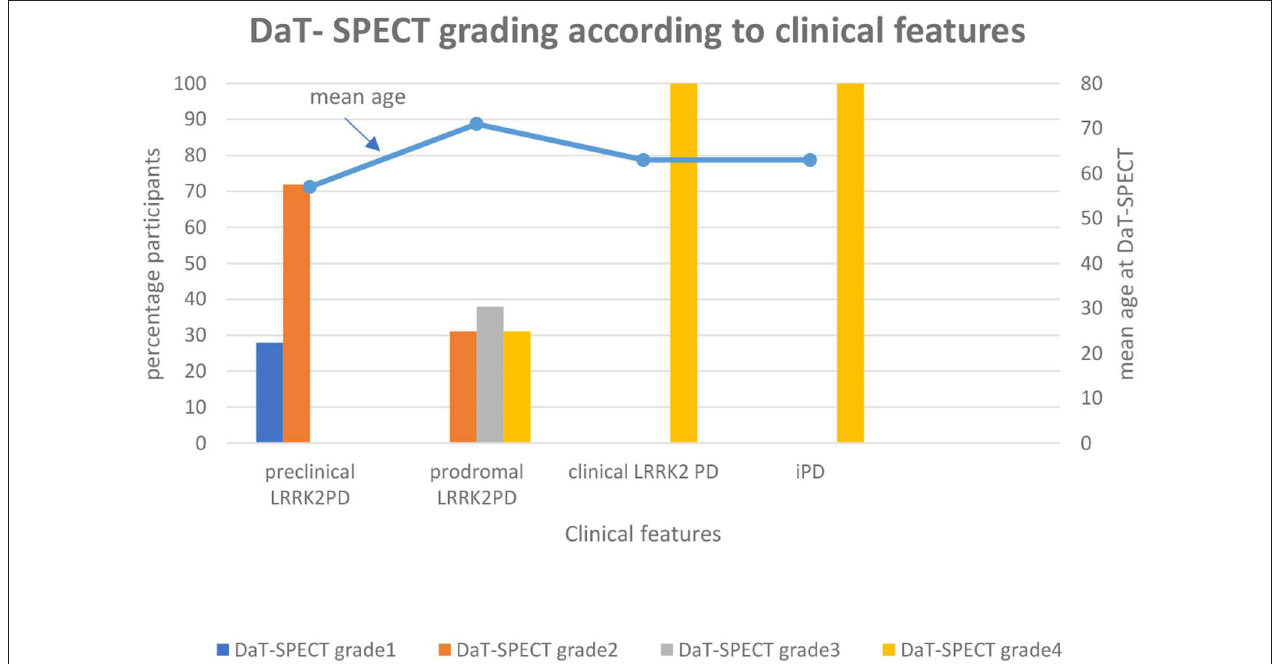
FIGURE 1 | In the preclinical LRRK2 PD group (UPDRSIII < 5), 28 percent (5/18) of the participants have normal DAT-SPECT scans and 72 percent (13/18) have abnormal DAT-SPECT scans grade 2 with an almost normal, symmetrical tracer uptake with a discrete reduction in one or both putamina. In the prodromal LRRK2 PD group (UPDRS III 5–10), all of the participants have abnormal DAT-SPECT scans: 31 percent (4/13) grade 2, 38 percent (5/13) grade 3 with an asymmetric tracer uptake with normal or almost normal uptake in the putamen of one hemisphere and reduced uptake in the contralateral putamen and 31 percent (4/13) grade 4 with a posterior- anterior degeneration pattern. In the clinical LRRK2 group and idiopathic PD group all of the participants have abnormal DAT-SPECT scans grade 4.